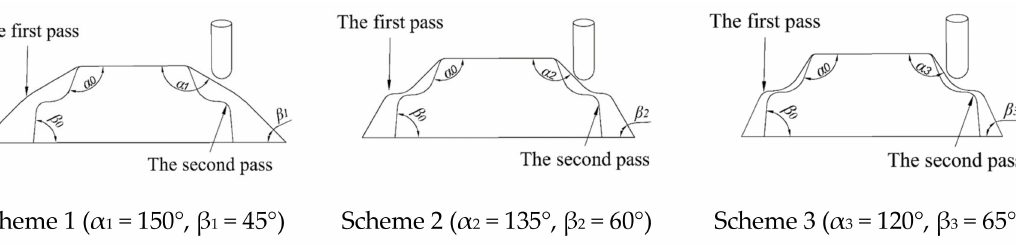
Figure 9. Forming angle schemes.